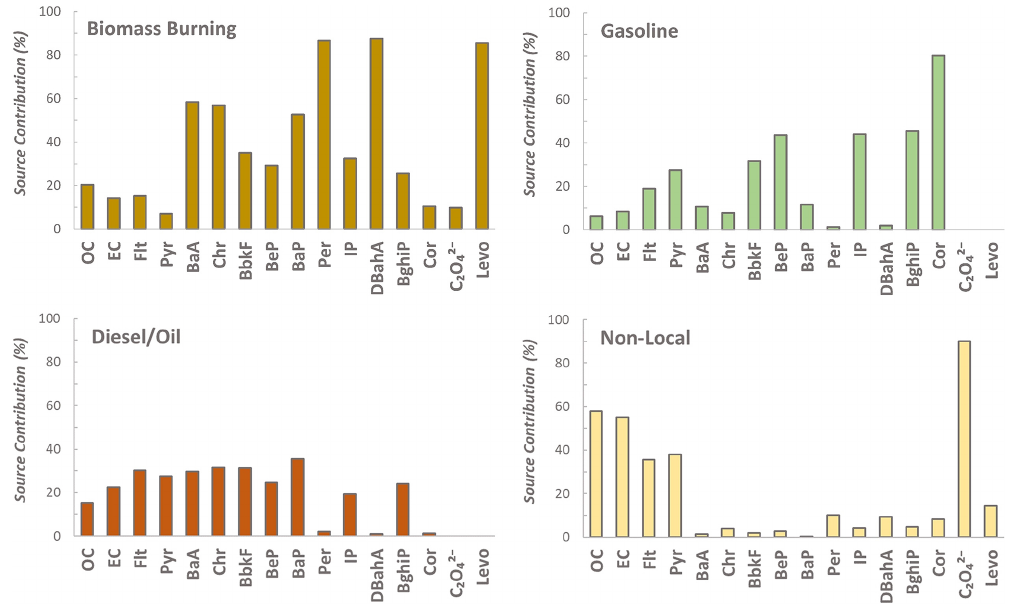
Figure 2. Percentage contributions of individual sources to mean modeled concentrations of PAHs and other carbonaceous species obtained from PMF analysis for 24h samples collected at Thissio, Athens, during December 2016–January 2018.